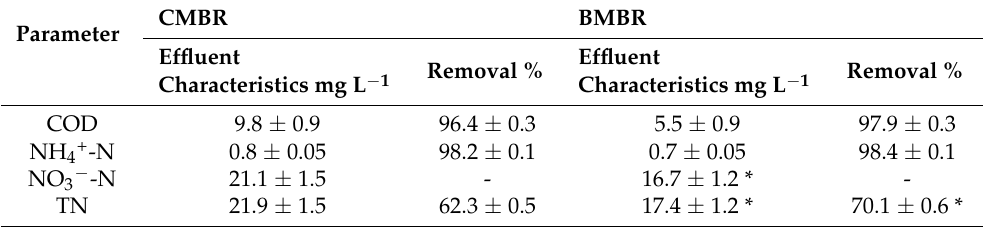
Table 1. Effluent characteristics from the conventional MBR (CMBR) and biochar MBR (BMBR) feeding with synthetic municipal wastewater under low C/N ratio of five. Parameter